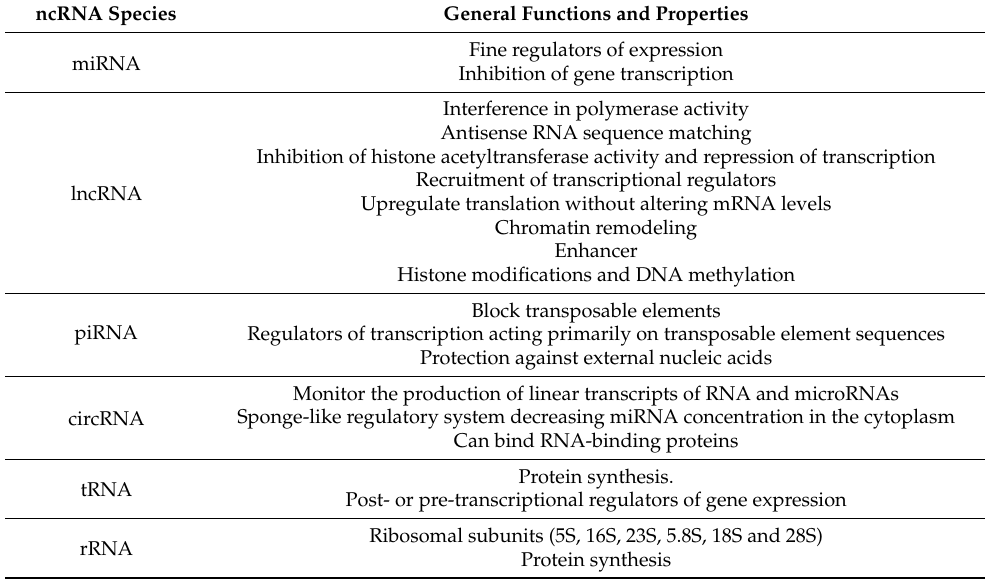
Table 1. Types of ncRNAs and their known